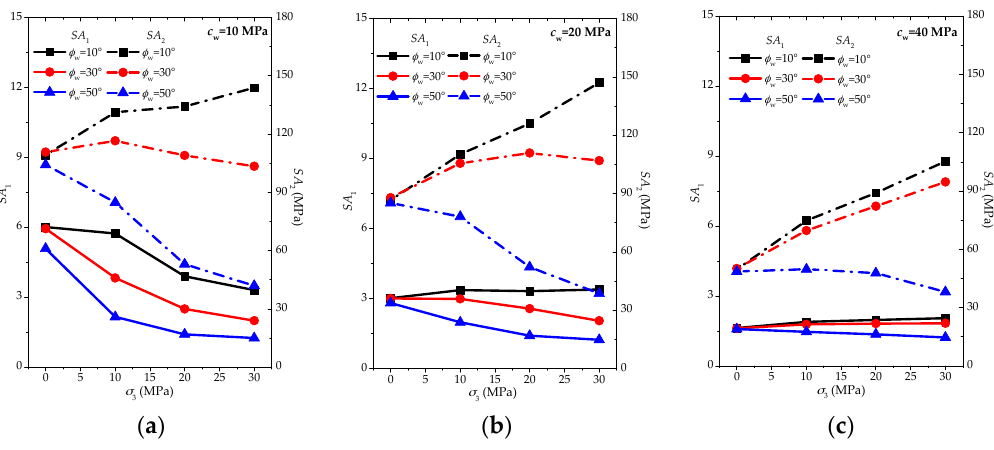
Figure 8. Influence of friction angle of weak planes with the certain cohesion ( a ) c w = 10 MPa ; ( b ) c w = 20 MPa ; and ( c ) c w = 40 MPa based on SA 1 (solid line) and SA 2 (dashed line).